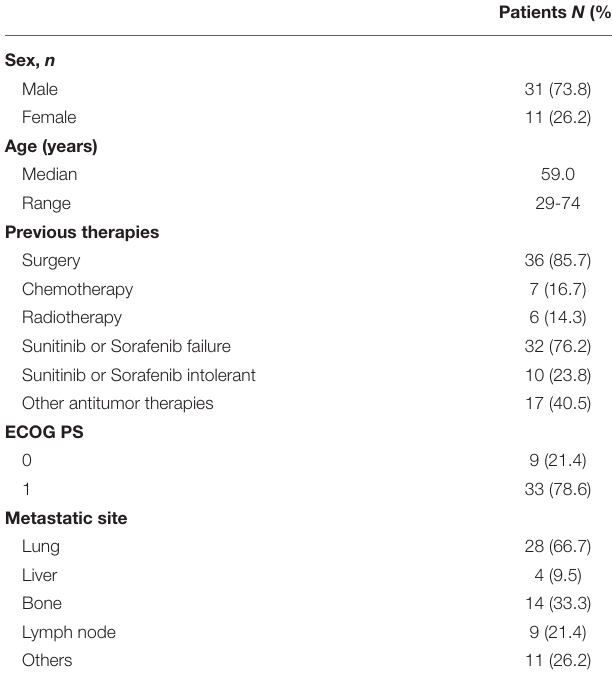
TABLE 1 | Patient clinical and demographic